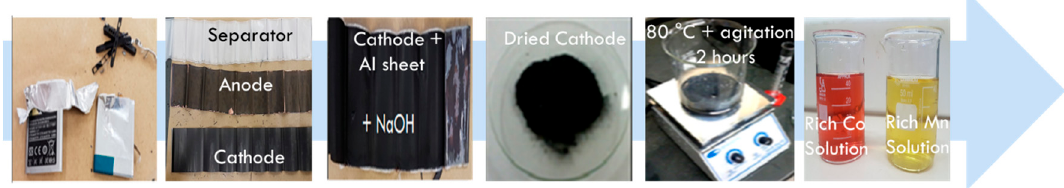
Figure 1. Illustrative scheme about the route for obtaining recycled electrolyte solutions.